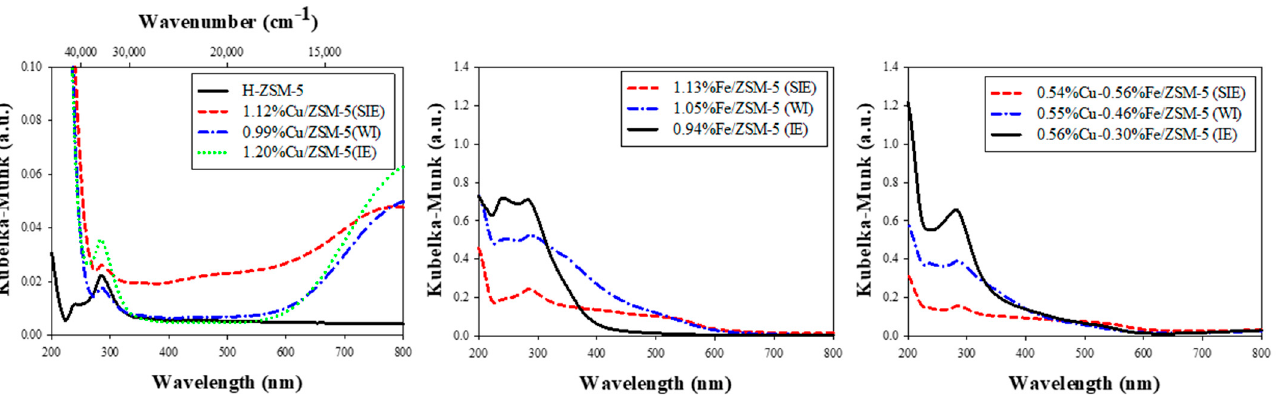
Figure 2. H 2 -TPR pattern of the catalysts prepared with different methods.